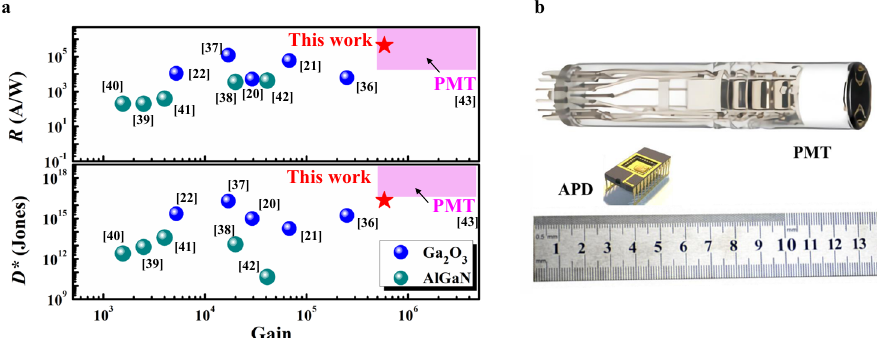
b Comparison of PMT and nBnunipolarbarrierAPD in terms ofsize, construction, and integration